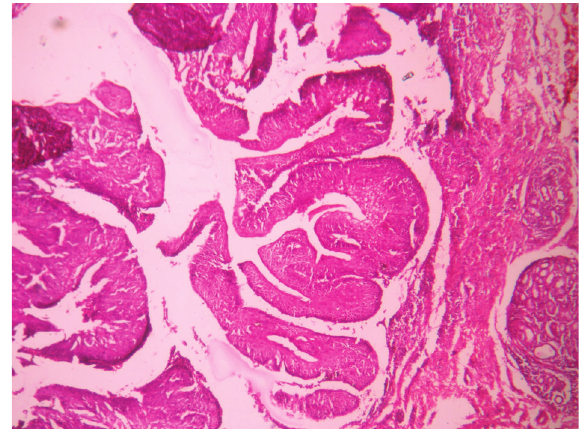
Figure 1: Surface papillary projections lined by a parakeratotic, acanthotic stratified squamous epithelium at 40x.